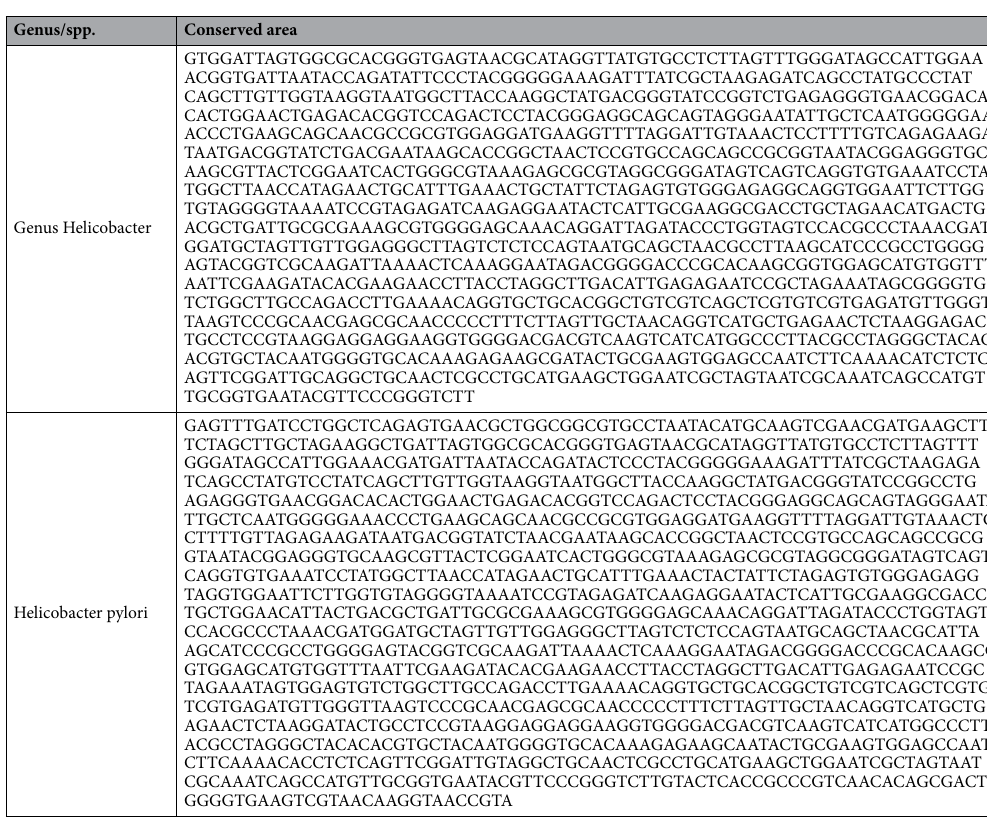
Table 1. The conserved sequence of 16srRNA gene in G: Helicobacter and H. pylori .